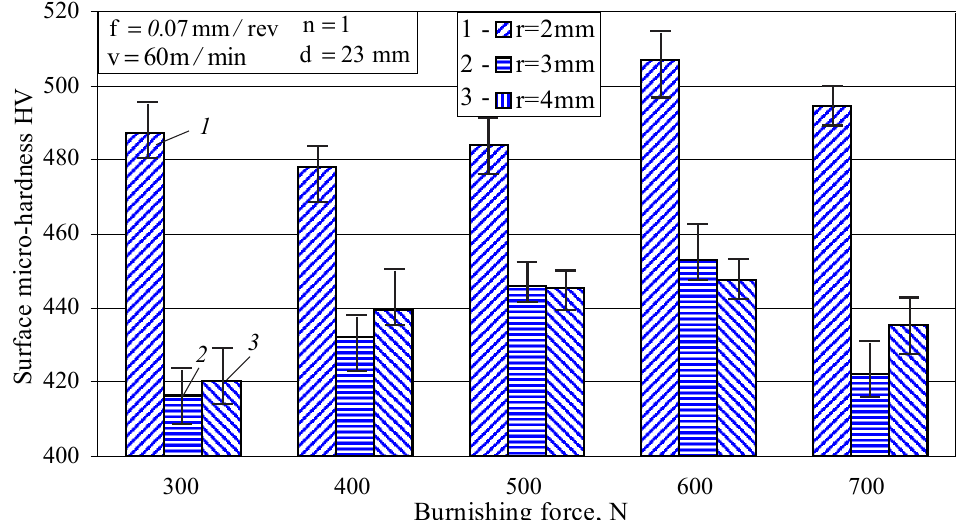
Figure 7. Effect of the radius and burnishing force on the surface micro-hardness.